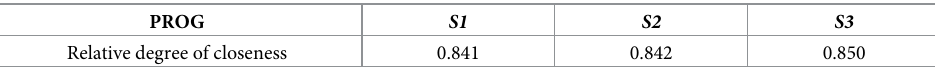
Table 7. Evaluation results of the relative degree of